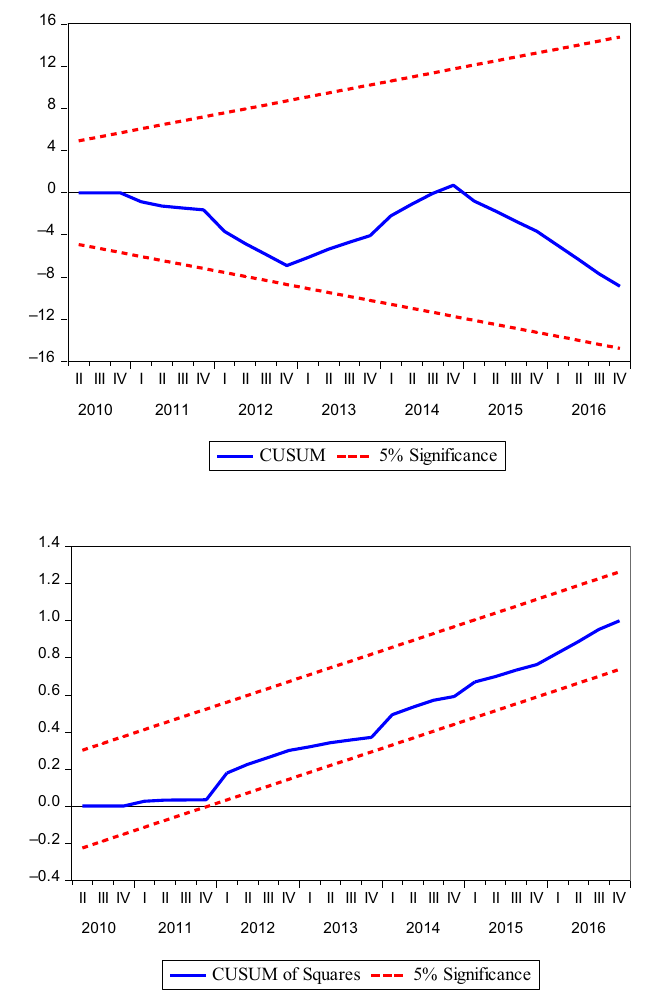
except for branch expansion, all the factors in our model are signi fi cant determinants of bank deposits in the long run. Our results further document branch expansion and broad money supply as the only signi fi cant determinants of deposit growth in the short run.